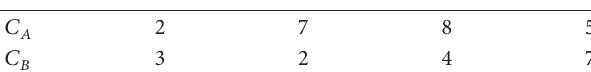
Table 4: Two individuals.